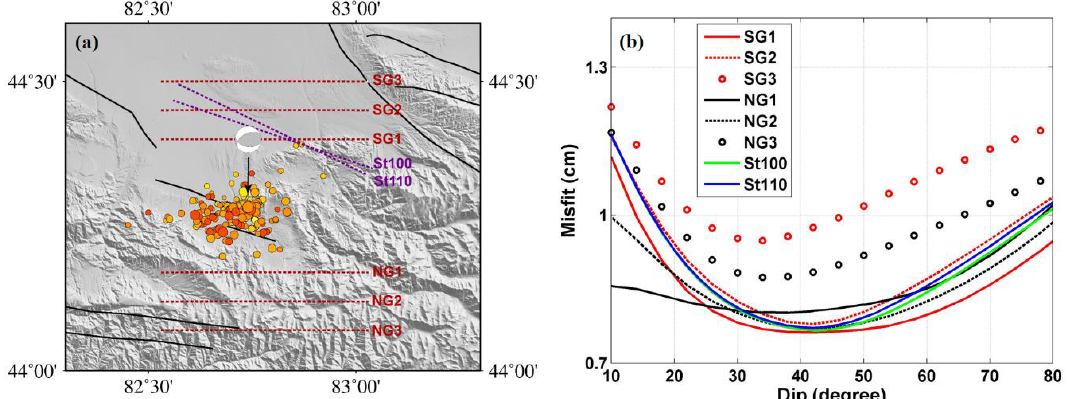
Figure 5. ( a ) Locations of candidate fault models overlaid with the local terrain and relocated earthquake sequence derived by Liu et al. [12] (circles); the colors of circles denote quake depths (light to dark corresponding to shallow to deep) and the radius denotes the magnitude. ( b ) Optimization of the dip angle for the different candidate fault locations.